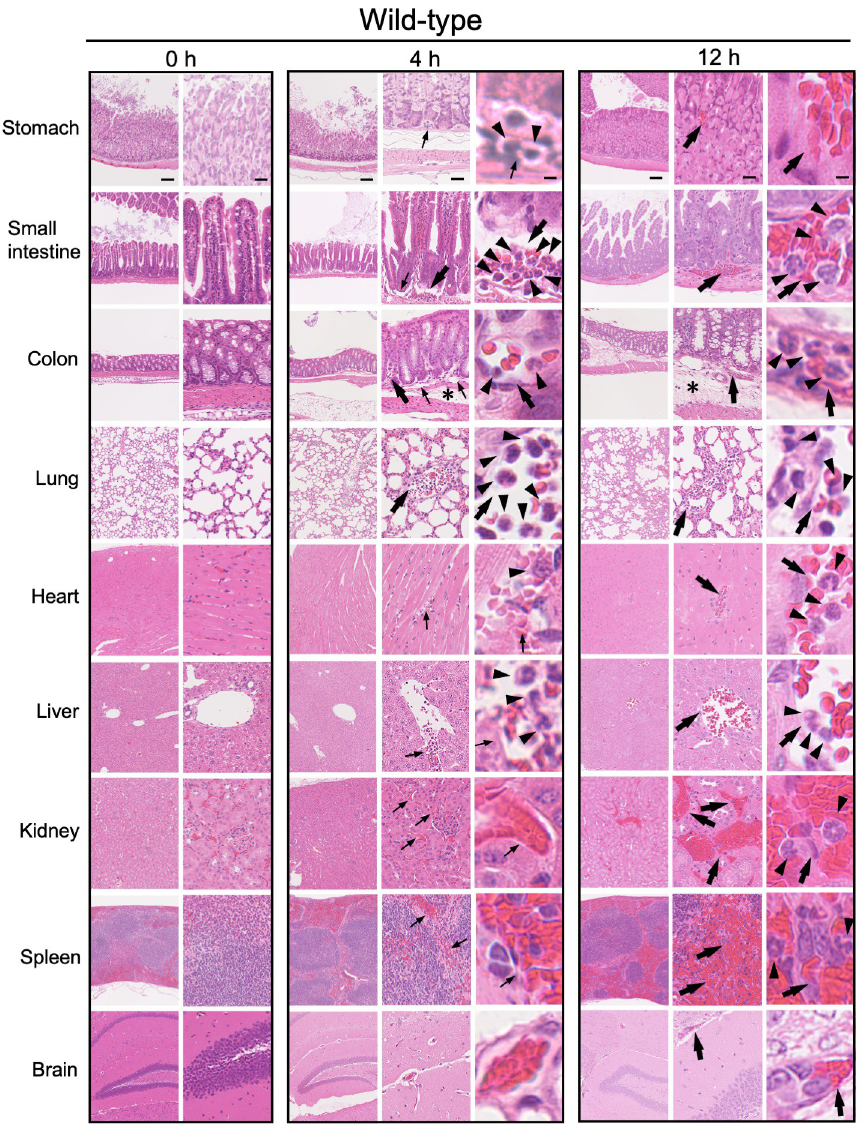
Fig 3. Histopathological images of tissues from WT mice after LPS challenge. Each image is representative of five mice. HE-stained images of the stomach, small intestine, colon, lung, heart, liver, kidney, spleen, and brain tissue from WT mice at 0 (0 h), 4 (4 h), and 12 hours (12 h) after LPS challenge. The asterisk indicates the submucosal edema. Capillary dilation is indicated by small arrows. Congestion is indicated by large arrows. Neutrophils are indicated by arrowheads. Bars, 100 μ m (low power view), 25 μ m (medium power view) and 5 μ m (high power view).